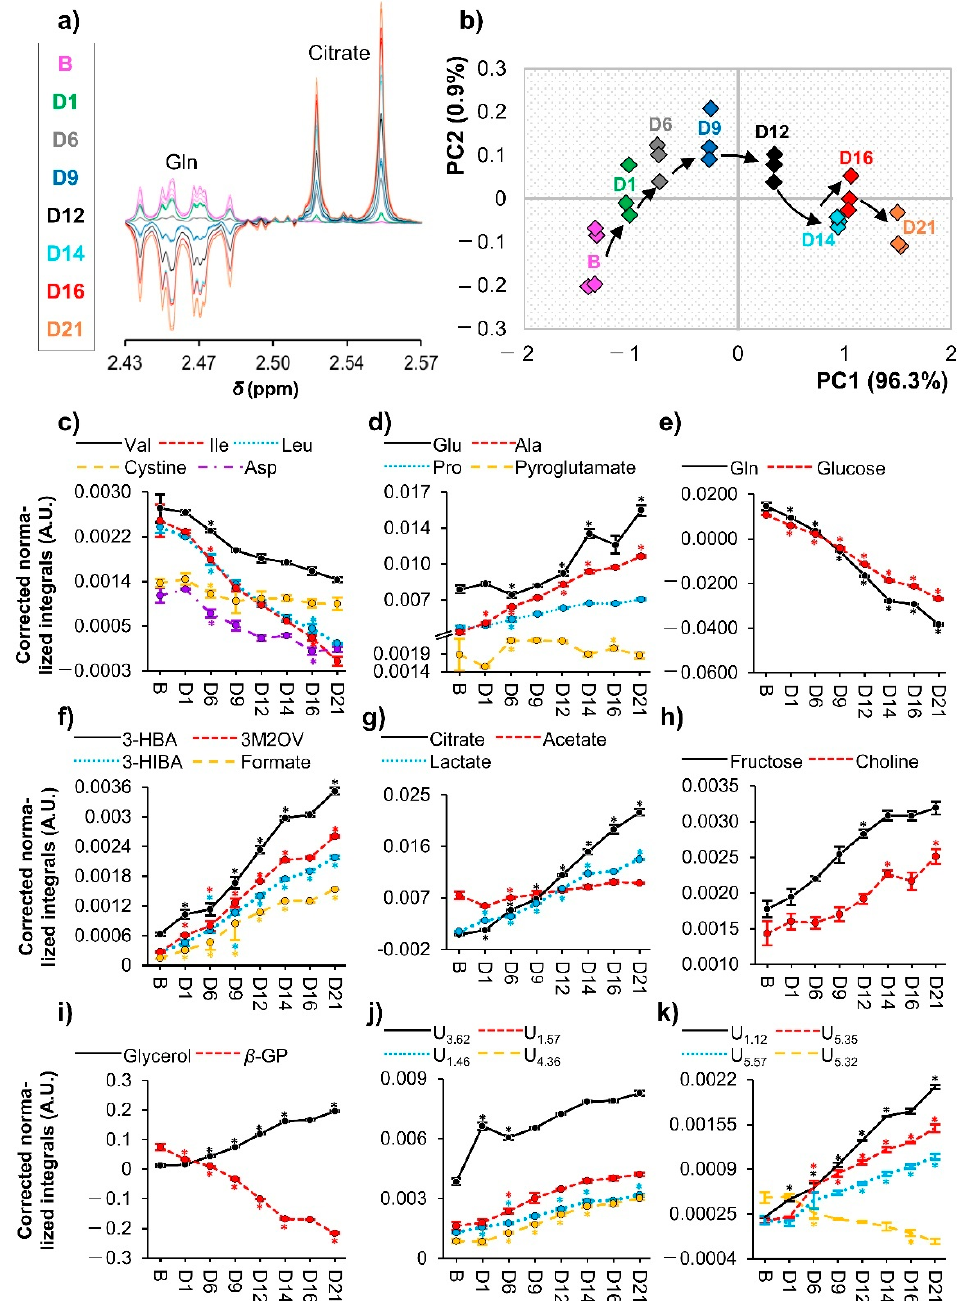
Figure 6. Main exometabolome variations throughout osteogenic differentiation. ( a ) Representative NMR spectral region corrected to compensate for the effect of media exchanges; ( b ) Scores scatter plots for principal component analysis (PCA) comparing osteogenic medium blank samples (n = 4) and samples collected throughout differentiation (at days 1, 6, 9, 12, 14, 16, and 21, each in triplicate); ( c –k) line graphs display the corrected normalized integrals over time for ( c , d ) some amino acids and derivatives. ( e ) glutamine and glucose, ( f , g ) organic acids, ( h , i ) other identified metabolites and ( j , k ) unassigned resonances. Three-letter code used for amino acids. 3-HBA, 3-hydroxybutyrate; 3-HIBA, 3-hydroxyisobutyrate; 3M2OV, 3-methyl-2-oxovalerate; and β - GP, β - glycerophosphate. B: blank (fresh) osteogenic medium samples; Di: day i; U δ : unassigned signal at chemical shift δ ; and *: Wilcoxon Rank-sum test p-value < 0.05 compared to the previous timepoint and represented in the same colour as the corresponding line (shown only in cases where spectral confirmation was ob- served).